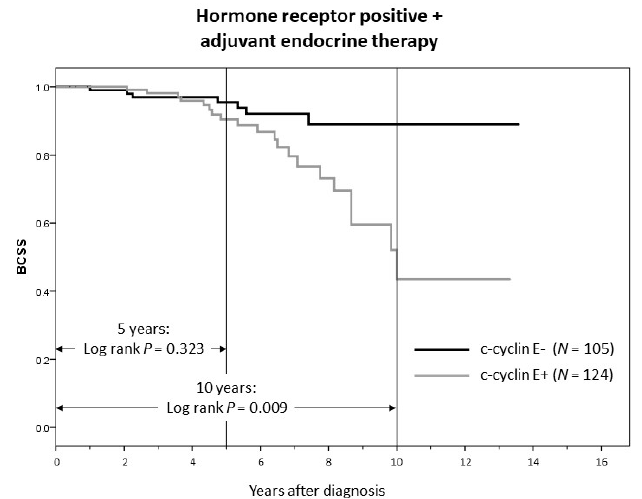
Figure 7. Adjuvant endocrine therapy negates the poor prognostic effect of c-cyclin E positivity, but only for as long as it is given (up to 5 years).